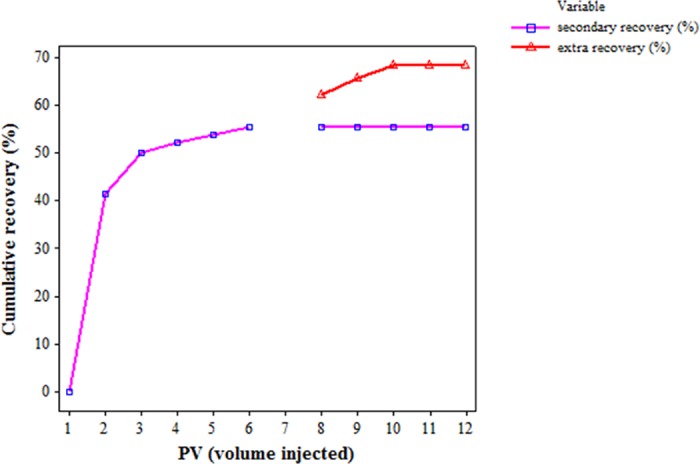
Cumulative oil recovery by P. ehimensis BS1.The extra recovery of the crude oil by the action of the isolate accounted for 10–13%.